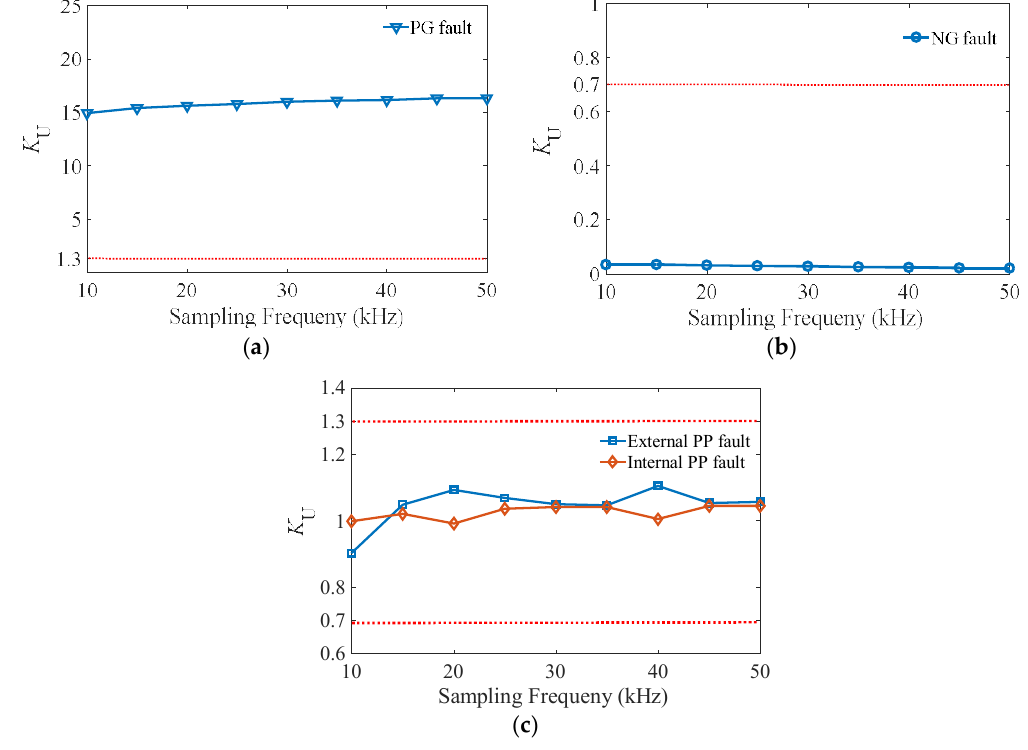
Figure 15. Simulation results for the influence of sampling frequency: ( a ) Positive-pole-to-ground (PG) fault; ( b ) Negative-pole-to-ground (NG) fault; ( c ) Pole-to-pole (PP) fault.